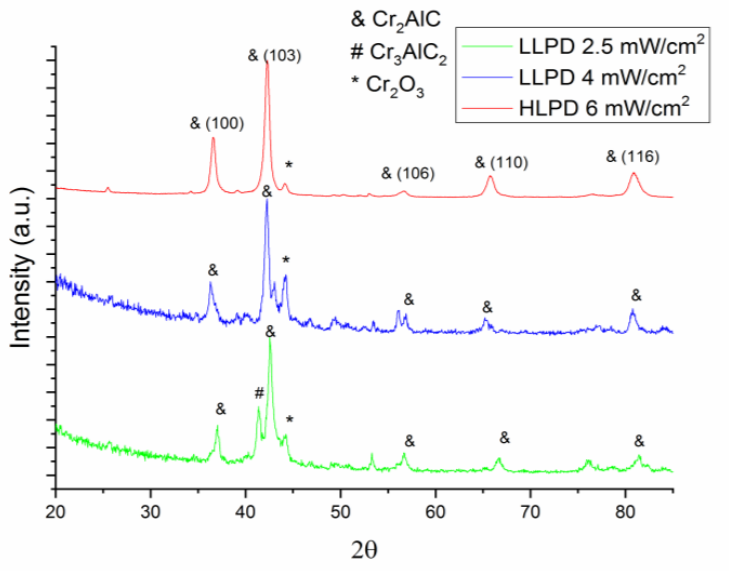
Figure 5. XRD patterns of the films as-deposited ( bottom ) and films annealed at 700 °C ( top ).